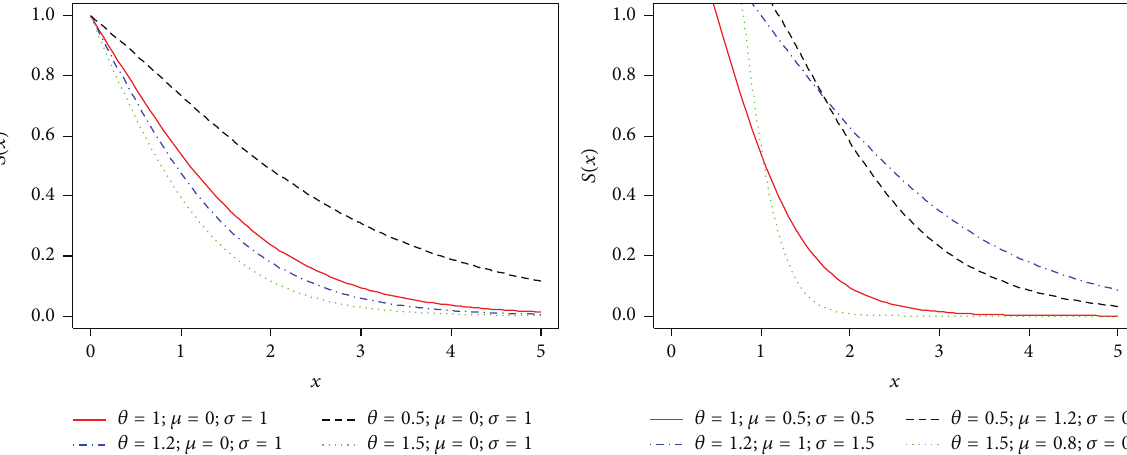
Figure 3: Survival function of the type I generalized half-logistic distribution for the indicated values of 𝜃 , 𝜎 , and 𝜇